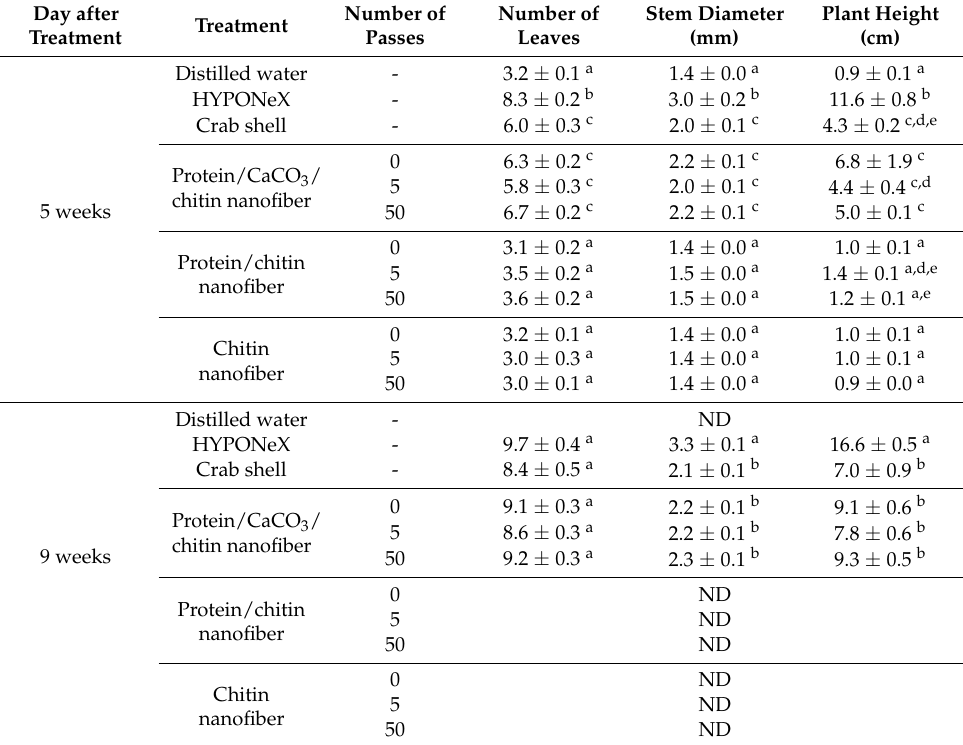
Data represents the mean of four independent experiments and error bars. Means with the same letter